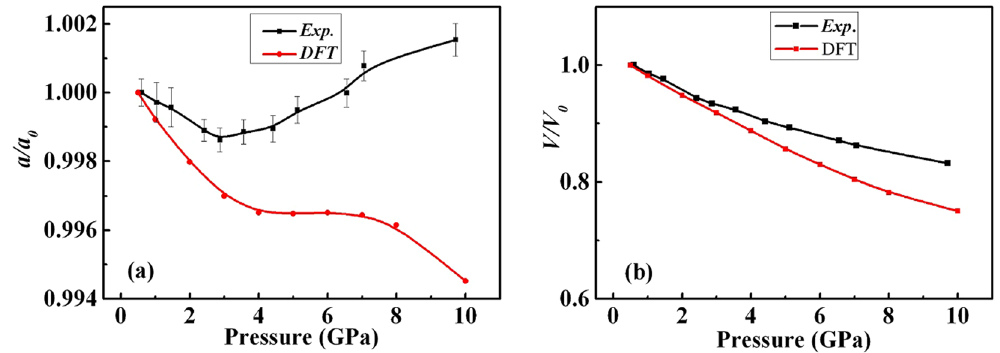
Figure 6. The relative changes of lattice parameter a/a 0 ( a ) and volume V/V 0 ( b ), where a 0 and V 0 correspond to the values at 0.5 GPa pressure for flux-KBBF. Black squares are experimental results and red dots are the DFT calculations. Solid lines serve as guides to the eye only. Note that the experimental error bars in ( b ) are smaller than the